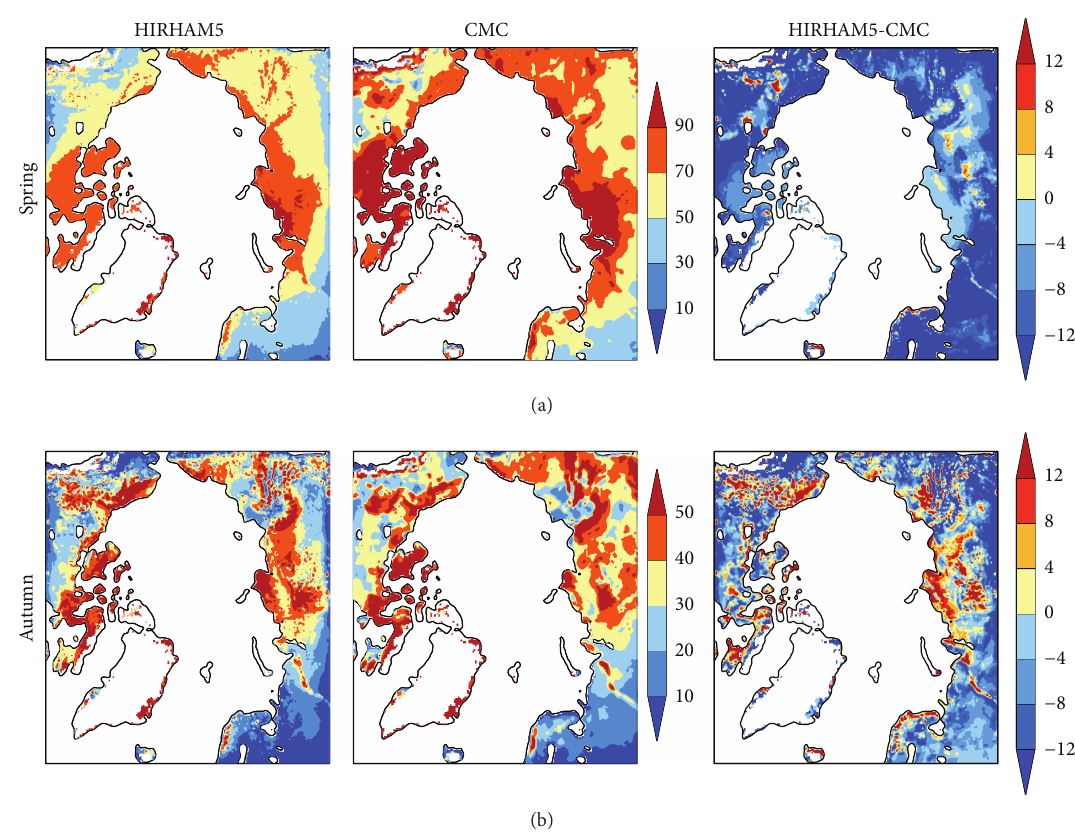
Figure 2: Snow cover duration (days) averaged over 2008–2010 for spring (a) and autumn (b) derived from HIRHAM5, CMC and their difference “HIRHAM5 minus